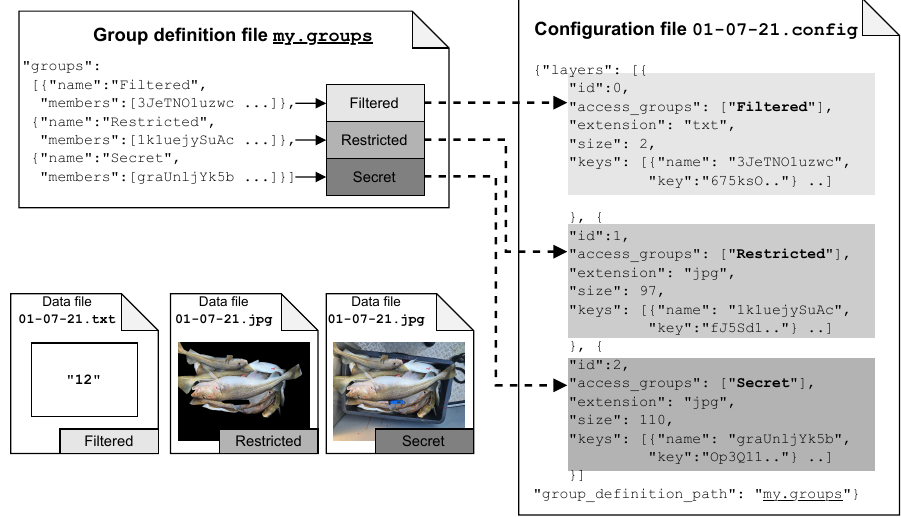
Figure 3. Definition of a configuration file, which defines access rights for a single data file, with its corresponding group definition file. The illustrated data file exists in three versions, one text file and two image